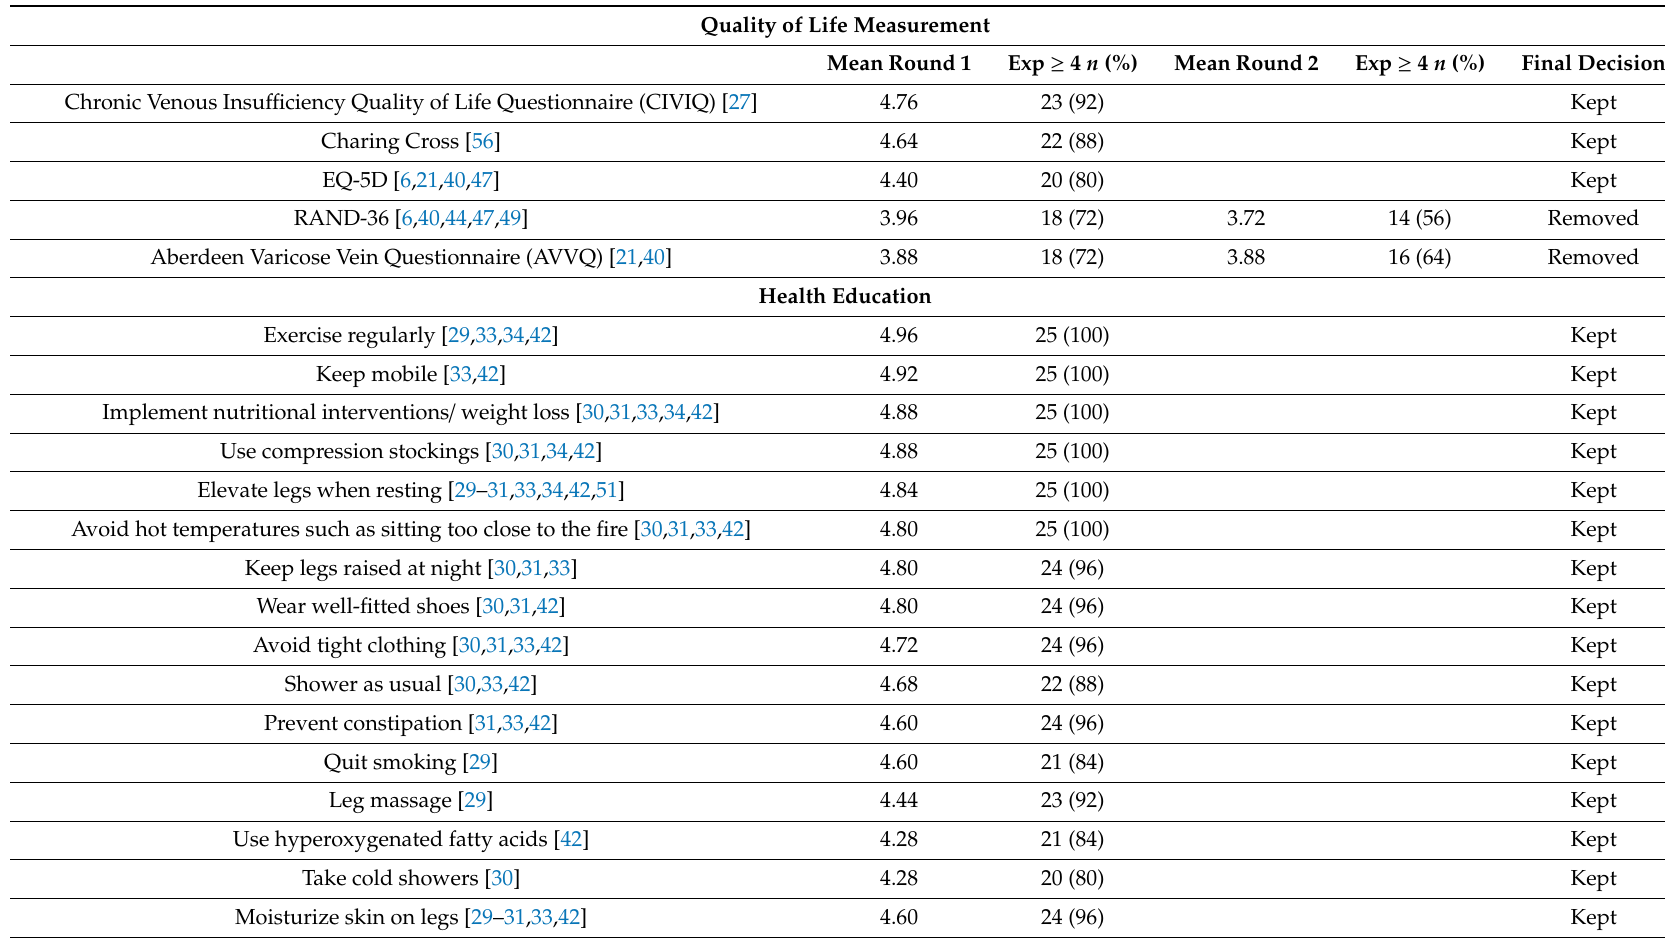
Table 4. Items related to quality of life measurement and health